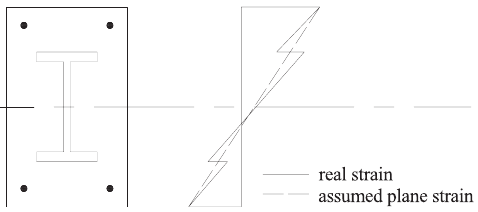
Fig. 4. Section strain diagram of